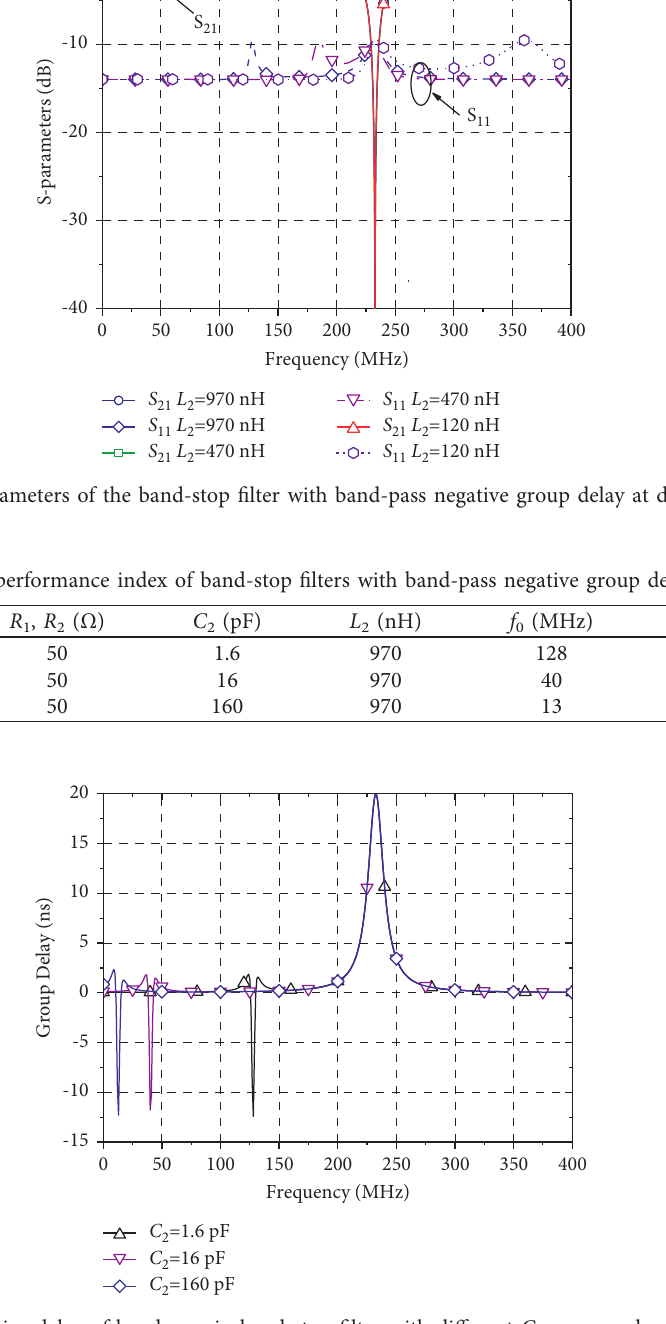
Figure 6: Negative delay of band pass in band-stop filter with different C